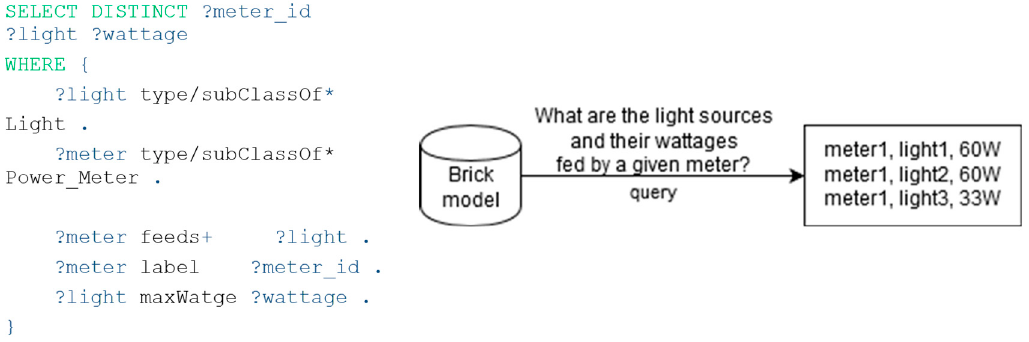
Figure 4. Query for collecting the wattages of lights being fed by each meter in SPARQL on the left. The sets are constructed from individual pairs in post processing. An illustration of the query question and example results on the right.